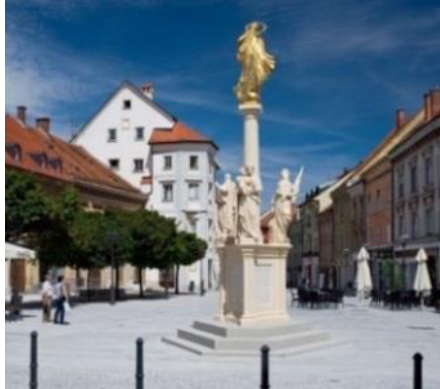
Fig. 8. The gathering places within the space Fig. 7.The maintenance of monuments within and the increase of afforestation. * space. *